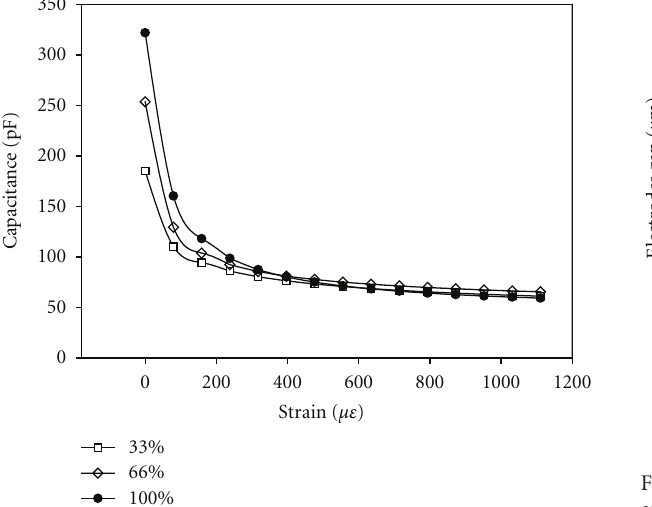
Figure 9: Comparison of simulation results.